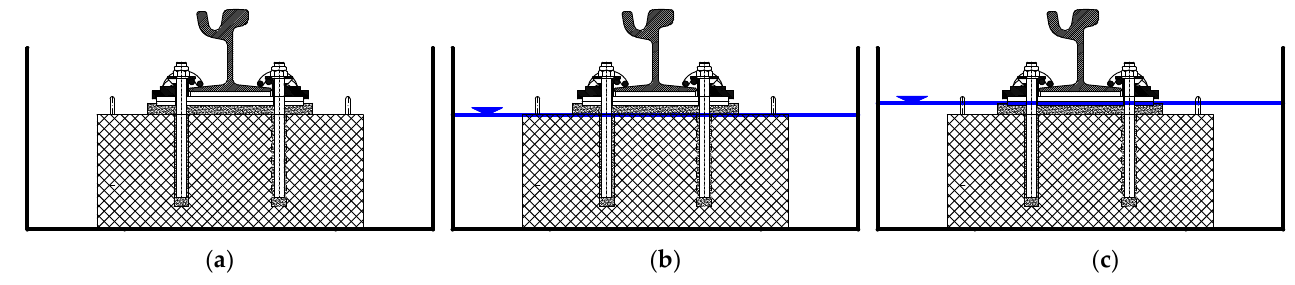
Figure 12. Conditions for the fastening system resistance measurement: ( a ) Case I: dry condition; ( b ) Case II: when the water is on top of the concrete base; and ( c ) Case III: when the water is on top of the levelling layer.